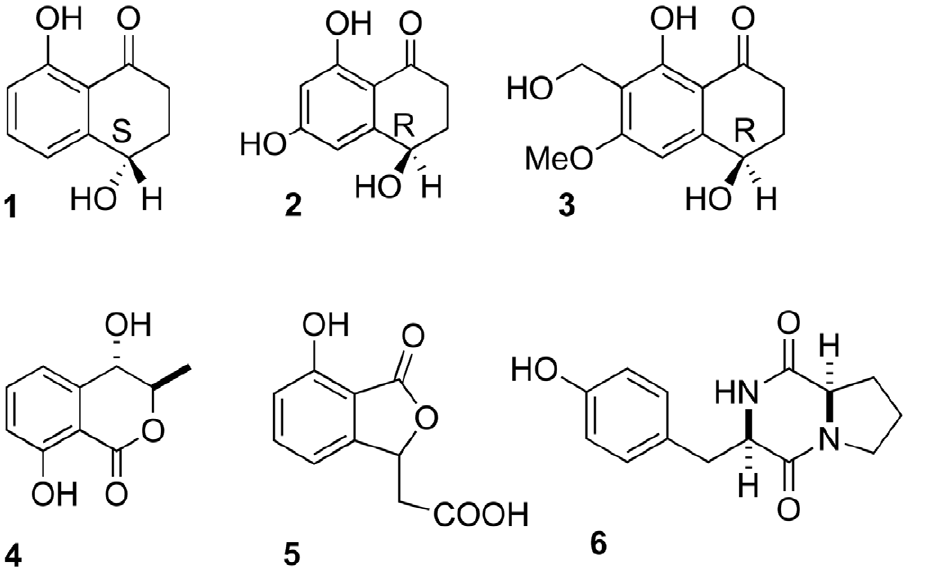
Figure 5. Structures of 1–6 isolated from P.variabile. All structures were assigned by detailed analysis (NMR spectroscopic and mass data).